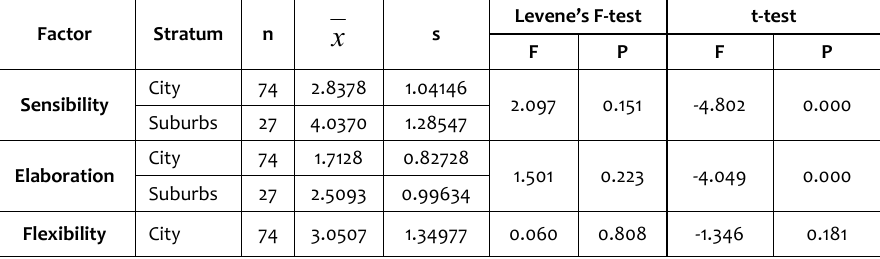
Table 2: Results of the t-test and Levene’s F-test of homogeneity of variances according to stratum in each factor of artistic creativity.